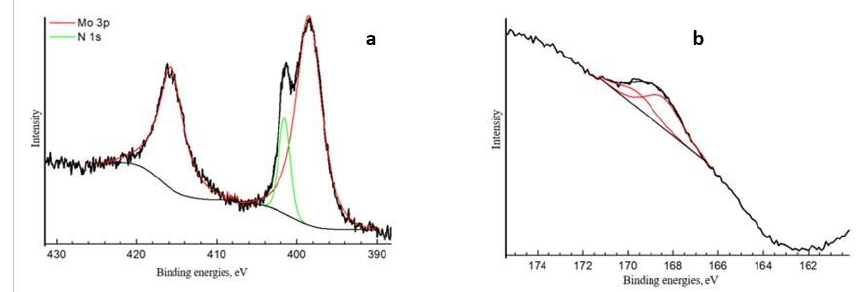
Figure A4. Mo3p/N1s ( a ) and S2p ( b ) XPS spectrum of the test sample.